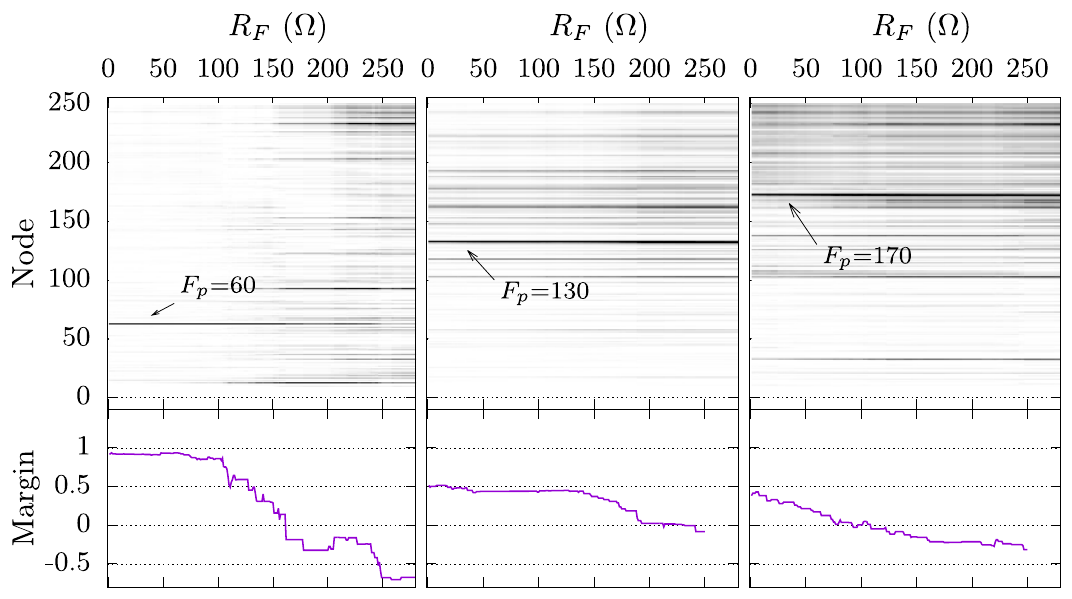
Figure 7. Heat Maps of m 2 and Margin ( m 2 (at fault point)/(max m 2 (all other nodes)) as a function of fault impedance R F .